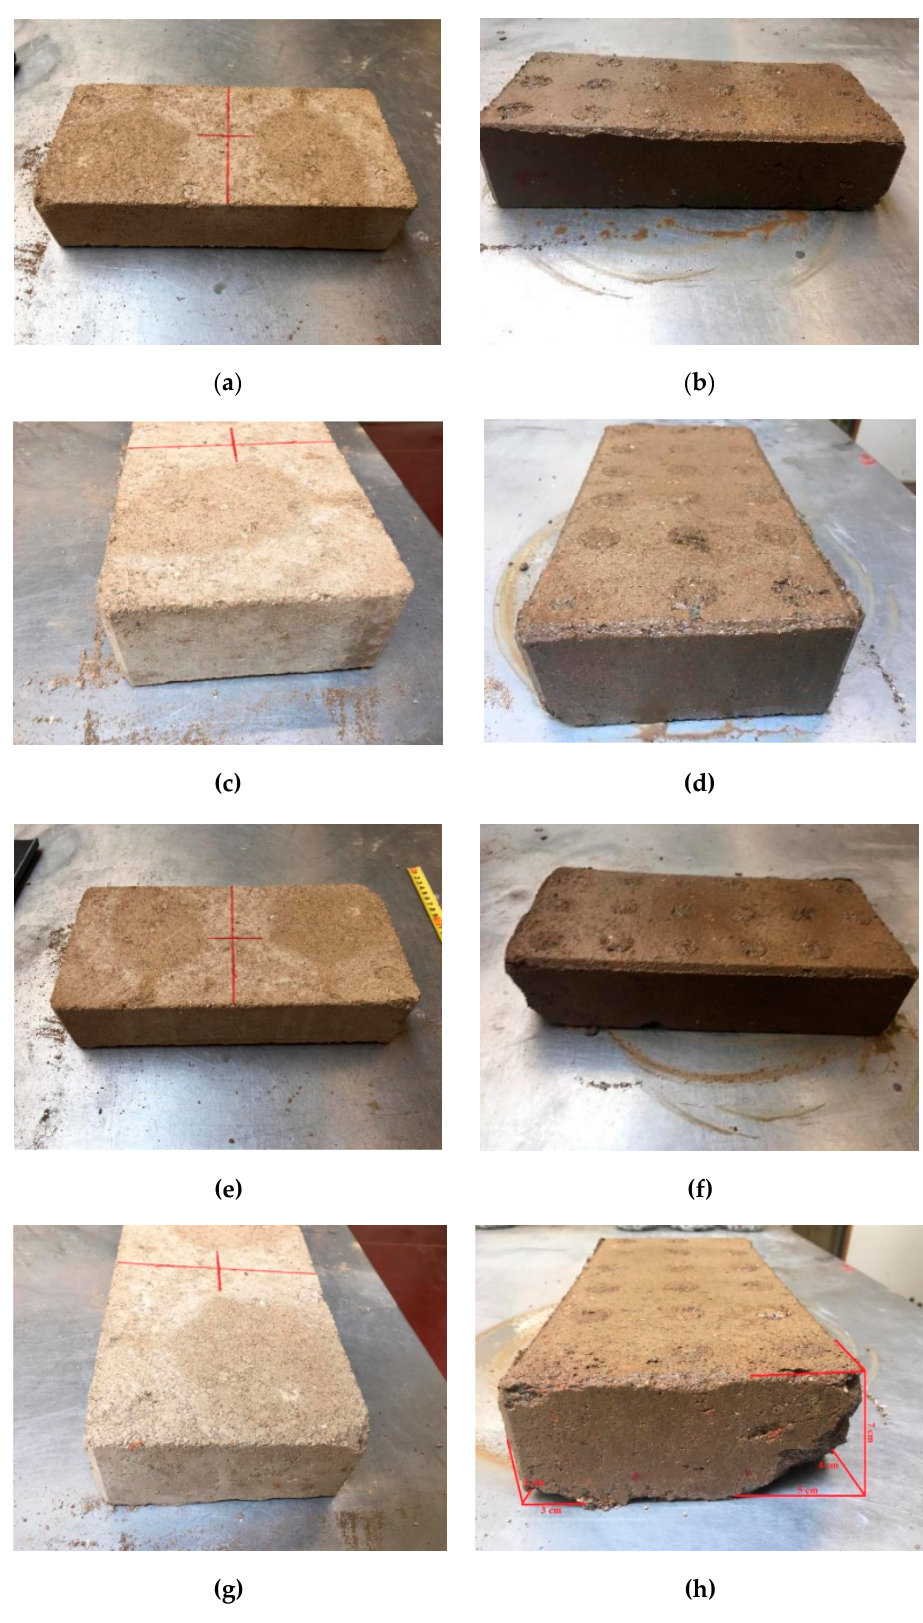
Figure 14. Accelerated erosion test. ( a ), ( c ), ( e ), and ( g )—four sides of the exposed face of sample 1 before the test; ( b ), ( d ), ( f ), and ( h )—four sides of the exposed face of sample 1 after two hours of testing.